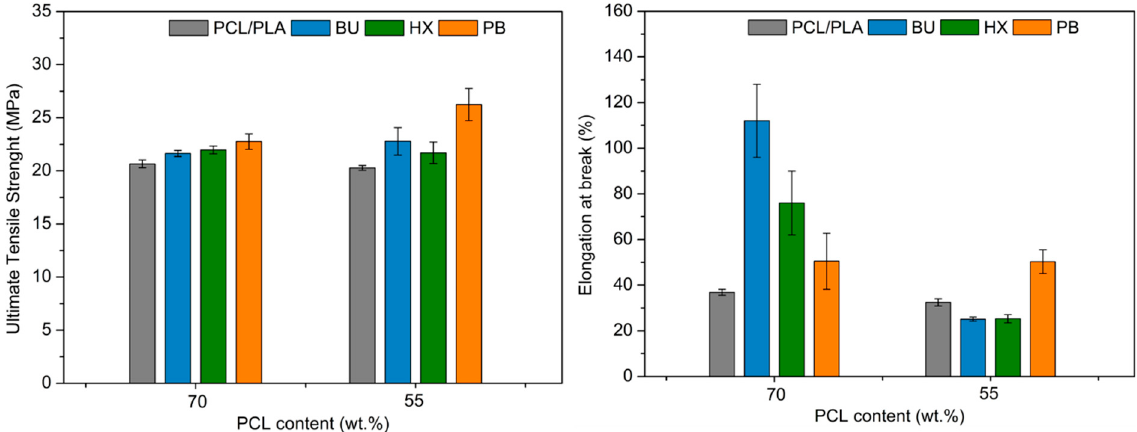
Figure 7. Ultimate tensile strength and elongation at break of PCL/PLA blends modified by OP. Graphs show the differences in mechanical properties as function th PCL content in the blends.